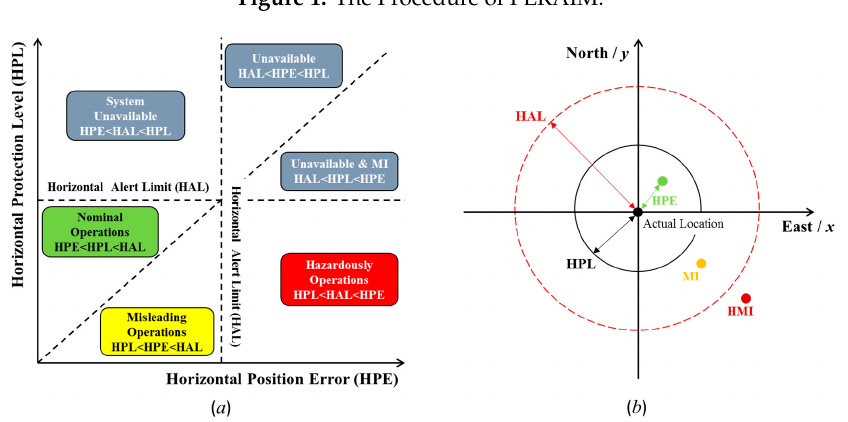
Figure 1. The Procedure of PLRAIM.